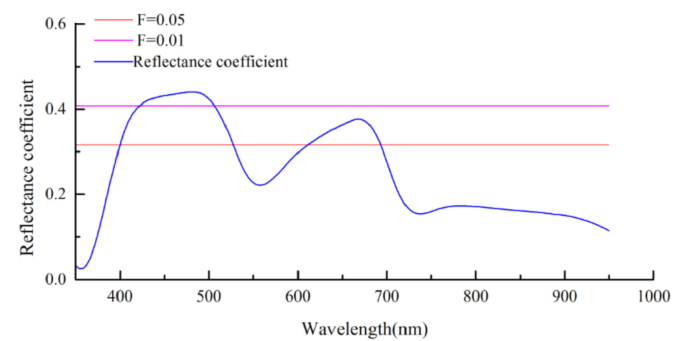
Figure 8. Correlation analysis between the spectral reflectance and coverage of S. chamaejasme community quadrats.